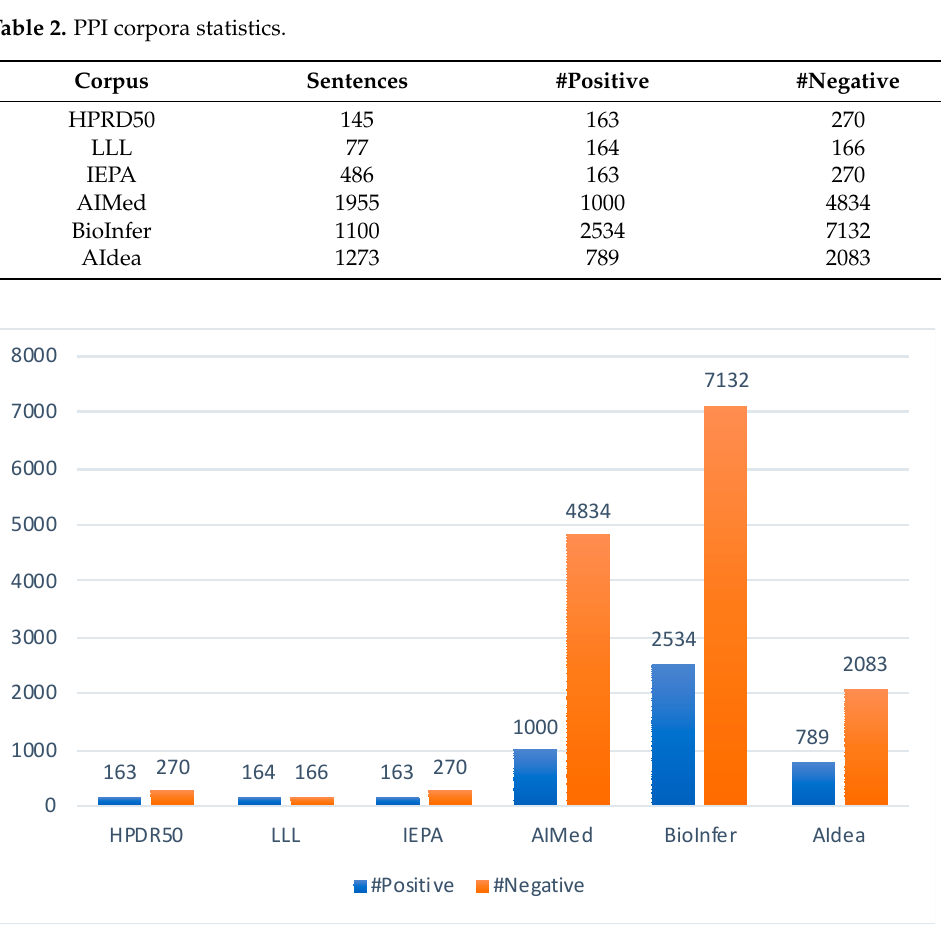
Figure 2. Distribution of PPI corpora used for performance evaluation.